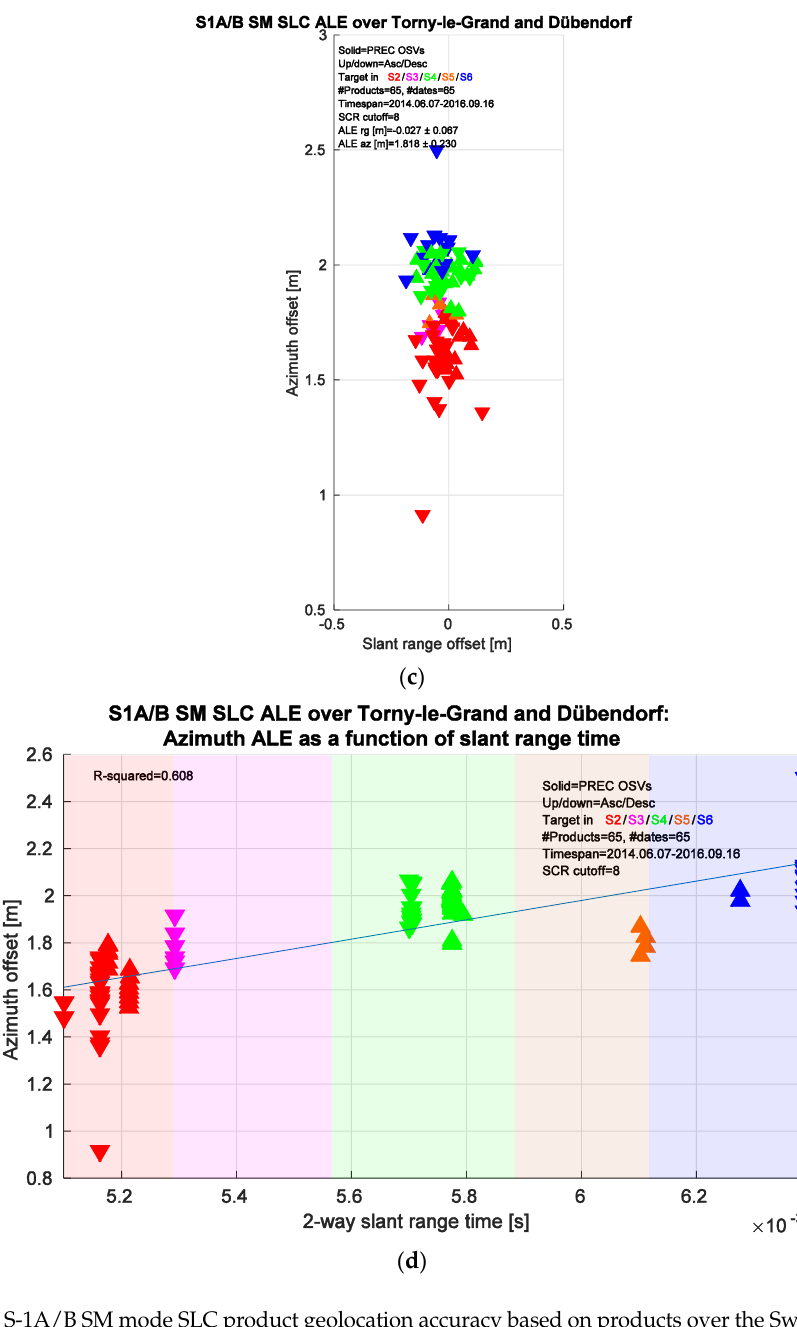
Figure 3. S-1A/B SM mode SLC product geolocation accuracy based on products over the Swiss test sites between 2014 and 2016: ( a ) S-1A; ( b ) S-1B; ( c ) S-1A/B combined; ( d ) azimuth error vs. slant range time for SM mode SLC products, with least-squares fit. Coloured regions indicate approximate beam ranges.